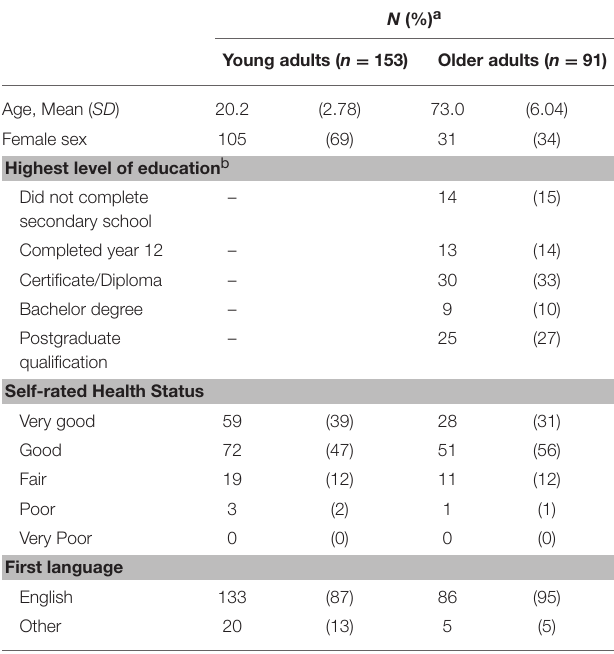
TABLE 1 | Characteristics of participants ( N = 244) including age, gender, highest level of education, self-reported health status, and first